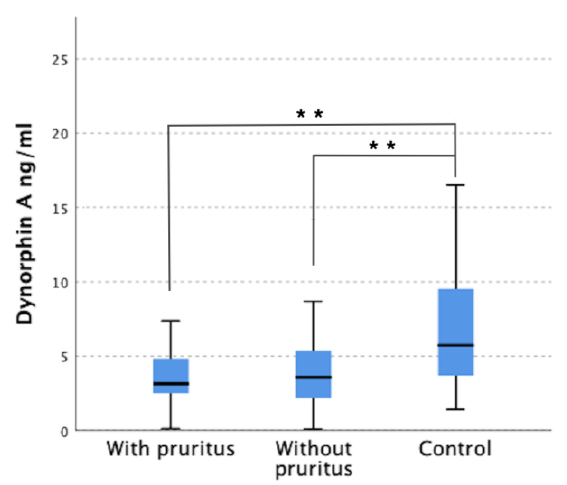
Figure 2. Serum level of Dynorphin A in patients with pruritus, without pruritus, and control group. ** p < 0.001.